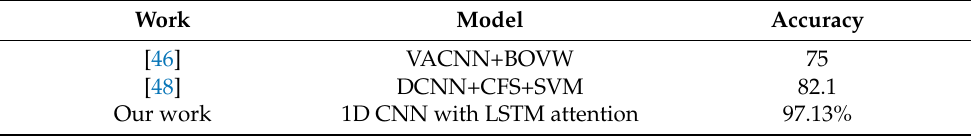
Table 7. Performance comparison of the works in the SAVEE dataset.